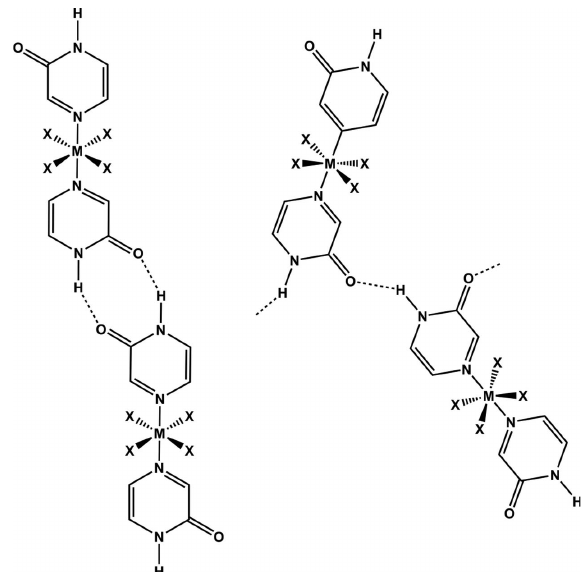
Figure 4 ð 8 Þ dimer and (right) the C (4) The two synthon types, (left) the R 2 2 catemer, formed between two basic metal-based building units equipped with pyrazinone ligands. The pyrimidinone and quinazolinone ligands are prone to exhibit the same hydrogen-bond